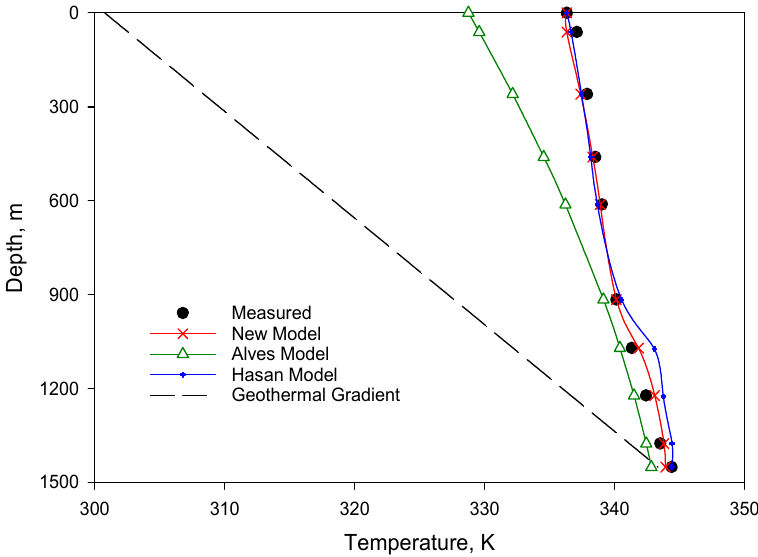
Figure 8. Comparison of data for the O’Connor Well.